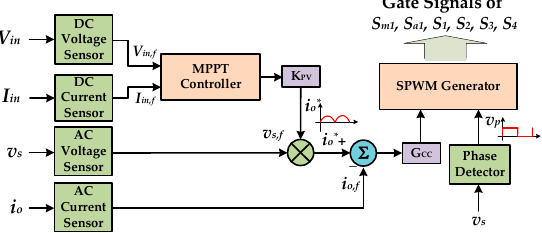
Figure 8. The block diagram of the control circuit of the PV grid-connection power system.